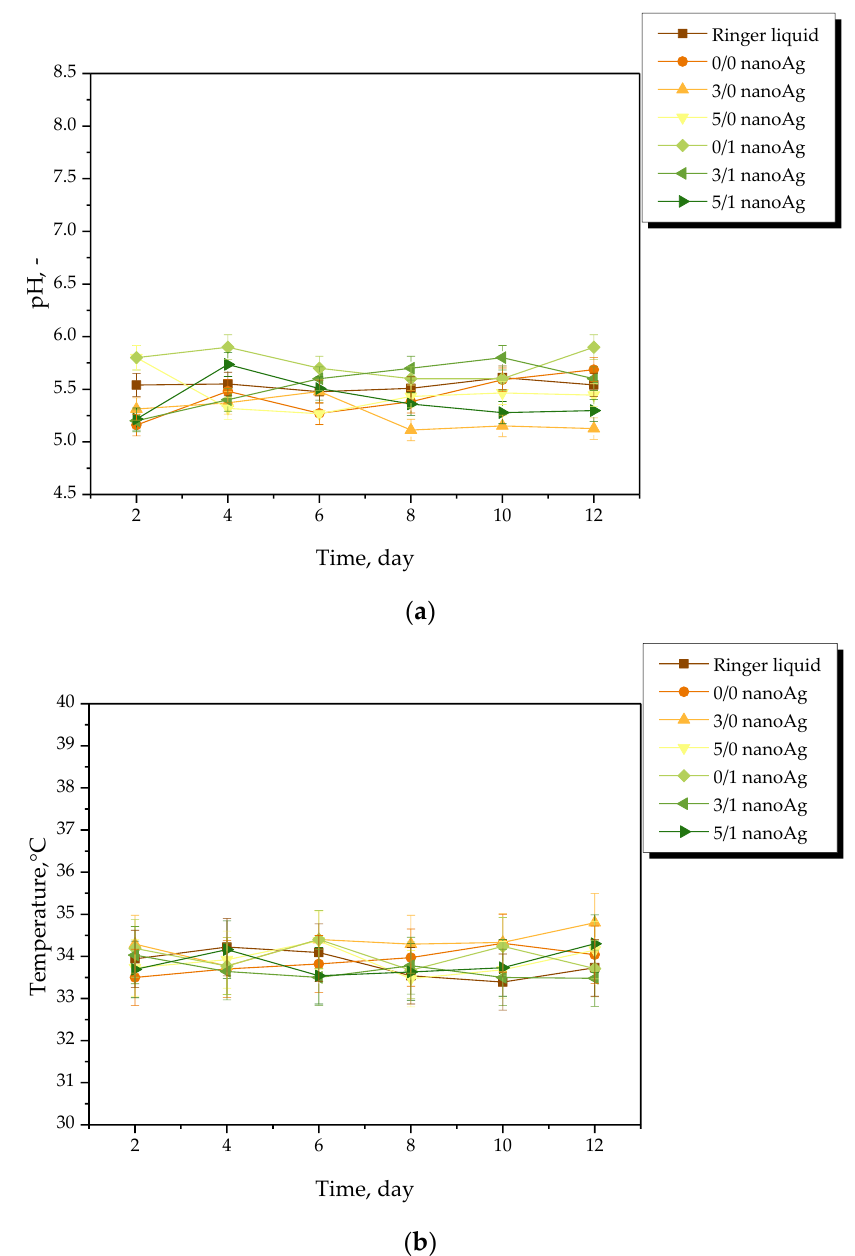
Figure 6. pH ( a ) and temperature ( b ) measurements of Ringer liquid during hydrogels’ incubation (n = 3, n — number of repetitions).